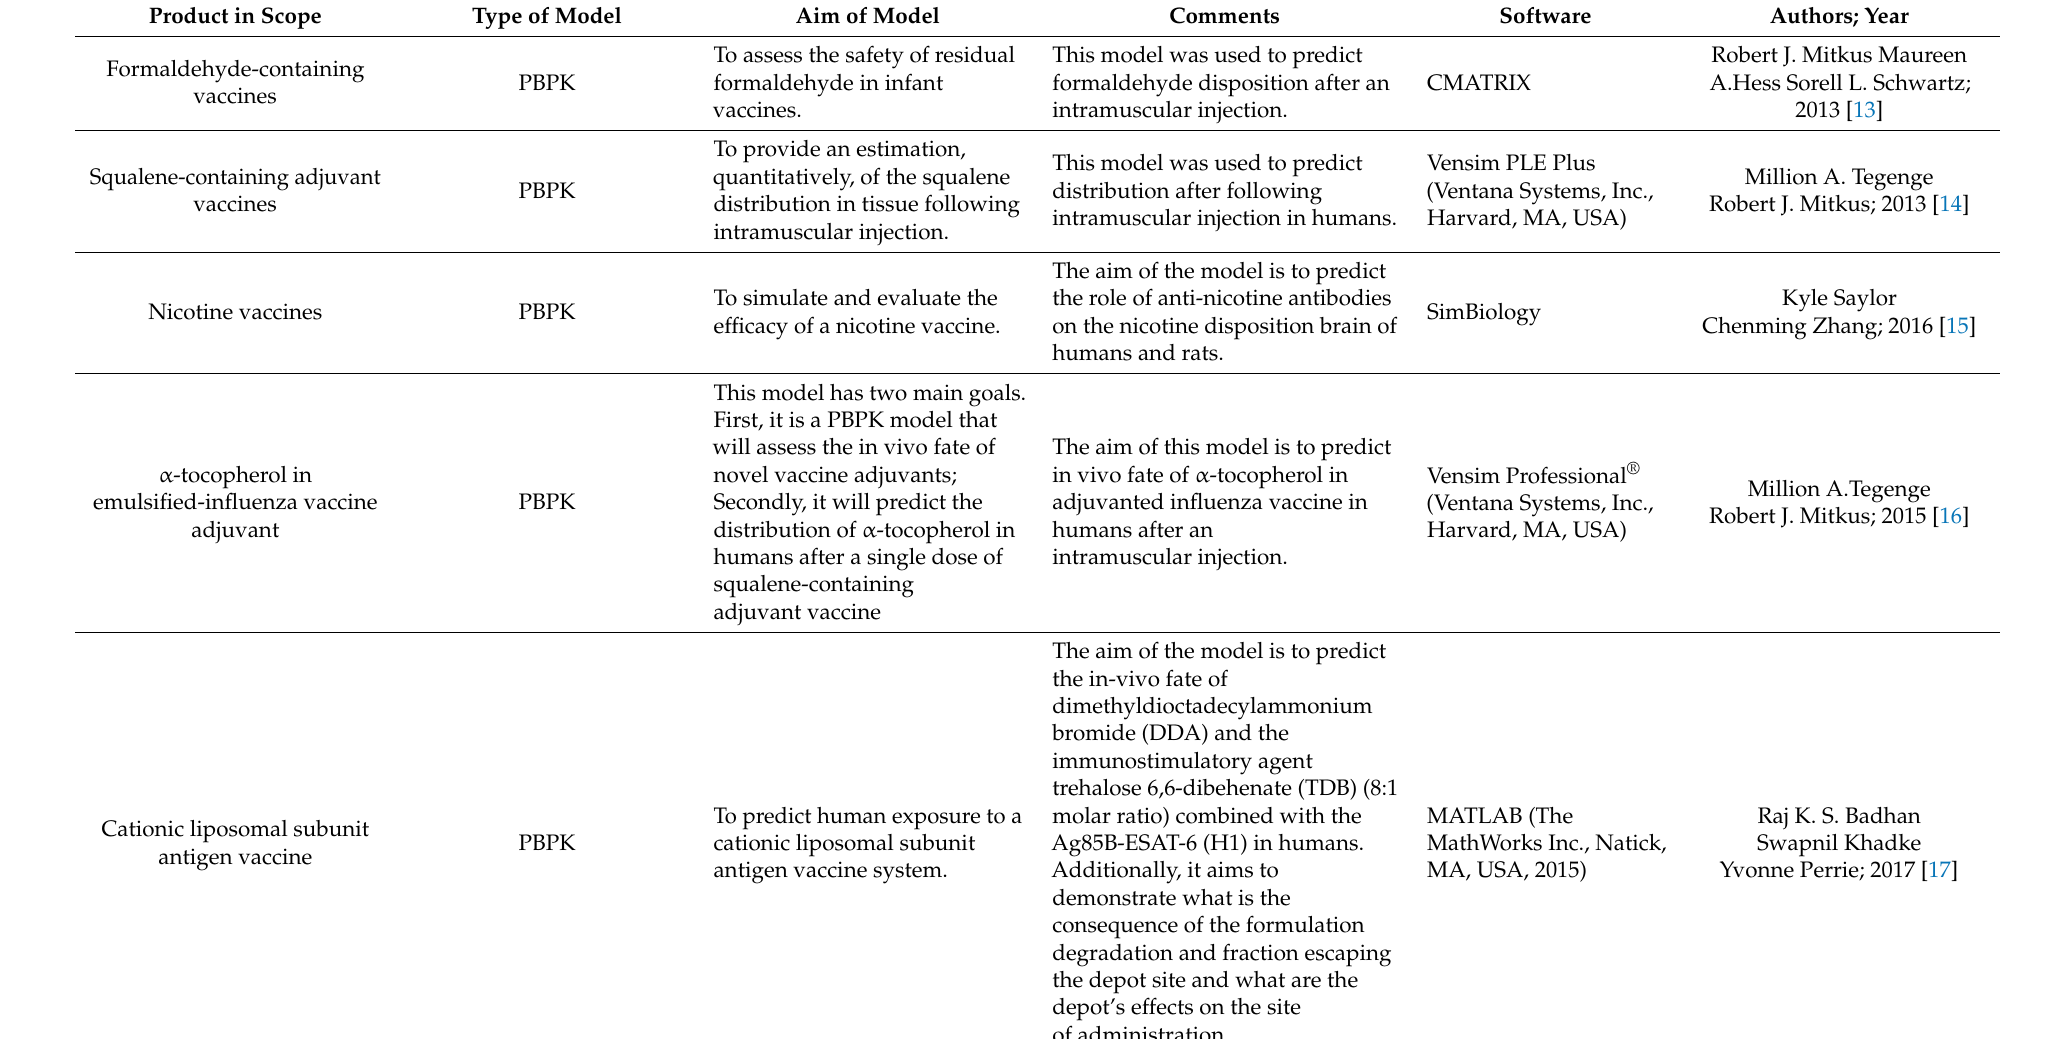
Table 3. Results from Phase 2 (Compilation of all in silico models to support vaccine